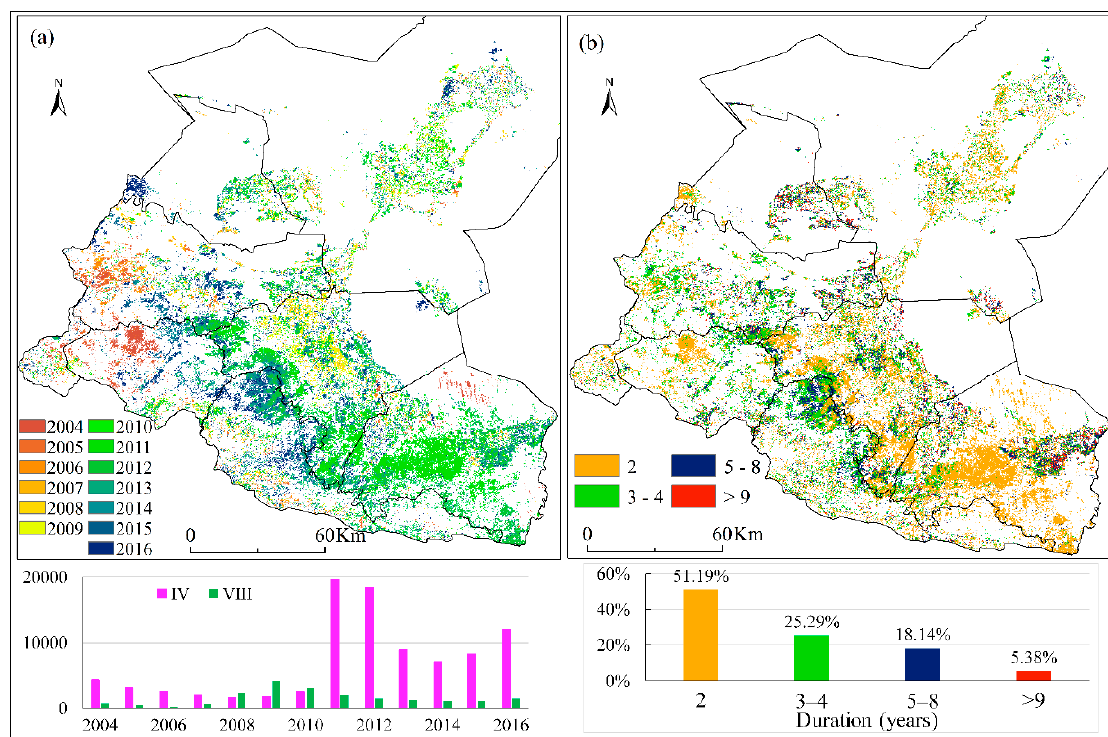
Figure 6. The second transition years ( a ) and the duration of vegetation changes ( b ) in the logistic pattern which has two transition years during the observation period. The number of pixels in each individual year for the second transition years are shown in the histogram below a. The histogram below b is the proportions of four duration periods.